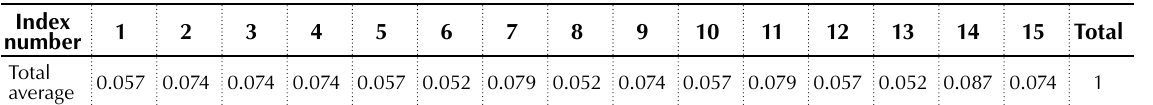
Table 4. The mean values of the questionnaire for determining the importance of each criterion in identifying the job control type (SRP1)